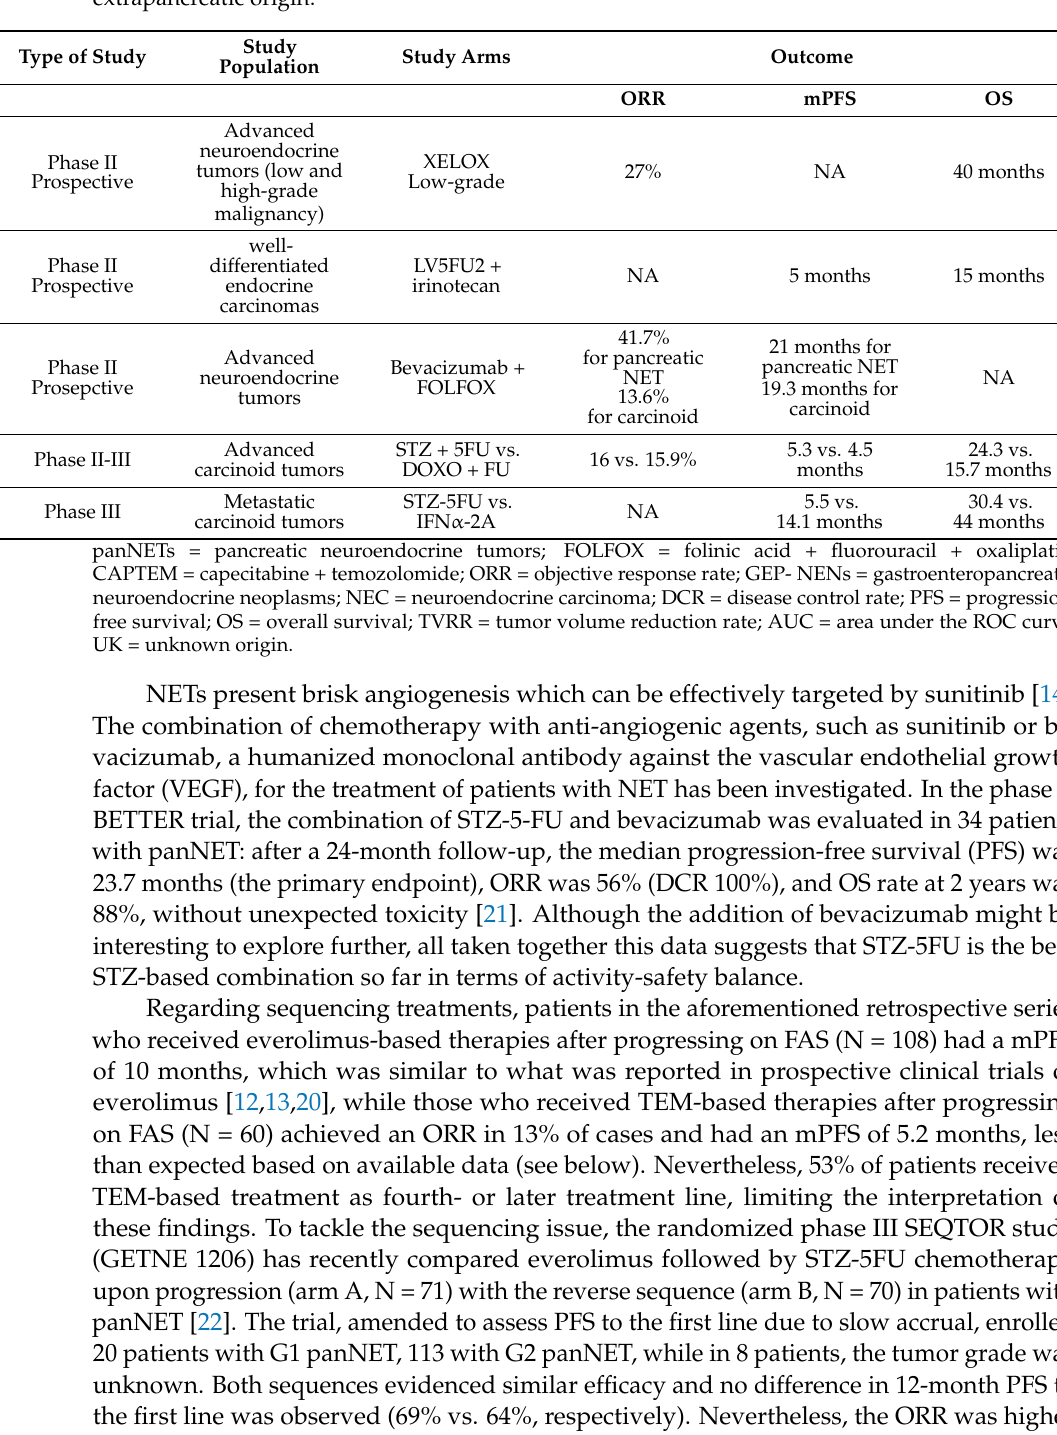
Table 2. Studies and trials of chemotherapy in G1-G2 NETs of both pancreatic and extrapancreatic